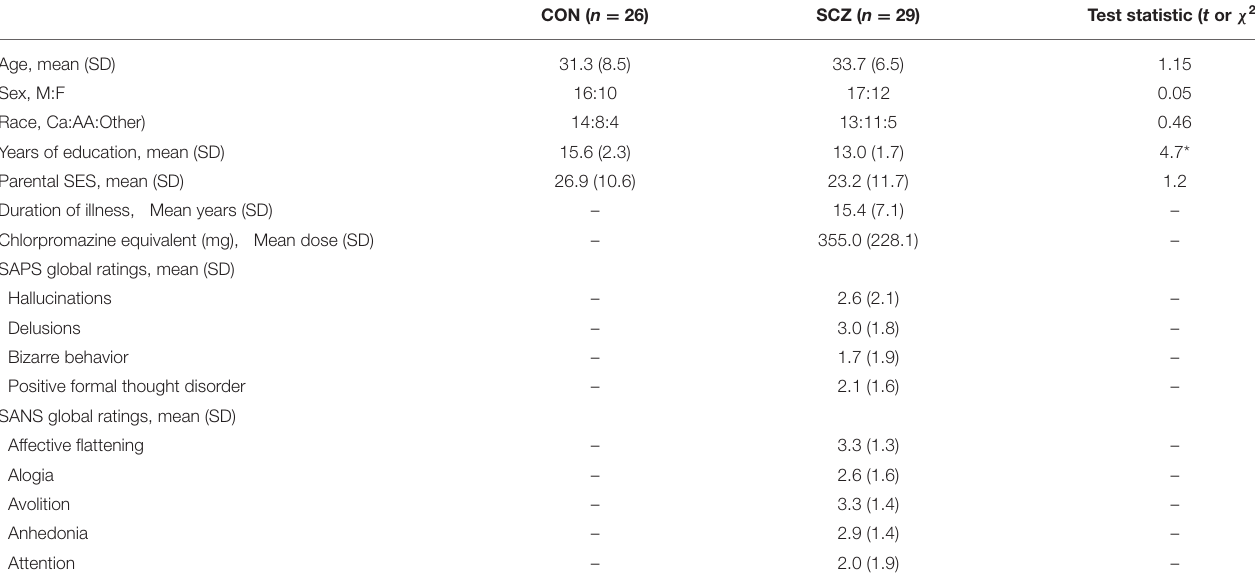
TABLE 1 | Demographic and clinical characteristics of study sample.